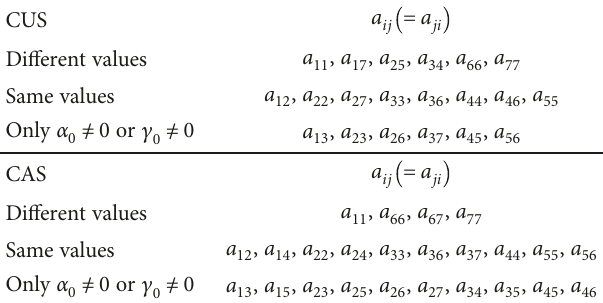
Table 4: Nonzero sti ff ness coe ffi cients of Model